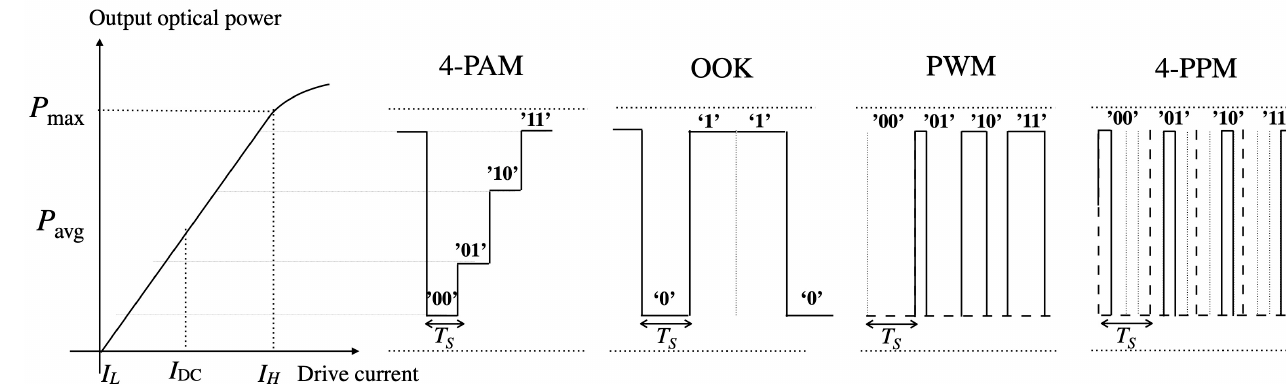
Figure 5. Dynamic range of the LED optical transmitter. Single carrier modulations: 4-PAM, OOK, PWM and 4-PPM. T S denotes the symbol